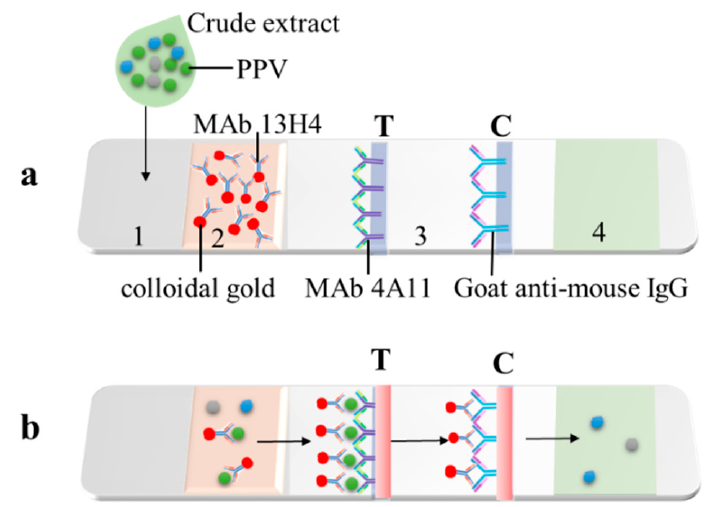
Figure 1. A schematic diagram showing the colloidal gold immunochromatographic strip. ( a ) Designs of CGICS strips. (1) a sample loading pad; (2) a CGNP-MAb 13H4 conjugate pad; (3) a nitrocellulose membrane with MAb 4A11 ( left ) and goat anti-mouse IgG antibody ( right ) at the testing (T) and control (C) line, respectively; and (4) an absorption cellulose fiber membrane pad. ( b ) Diagram showing working principle of the strip. Crude extracts from tree leaf samples are individually dropped to the sample pad. If a sample is infected with PPV, the CGNP-conjugated MAb 13H4 will bind to PPV virions (green dots) at the conjugate pad. The complex migrates to the nitrocellulose membrane and is captured by anti-PPV MAb 4A11 at the T line to form a first red band, whereas the free CGNP-conjugated MAb 13H4 passes through the T line and then is captured by goat anti-mouse IgG second antibody at the C line to form a second red band. The remaining sample will move and accumulate in the absorption pad. The grayish and blue dots represent different plant proteins in the samples.